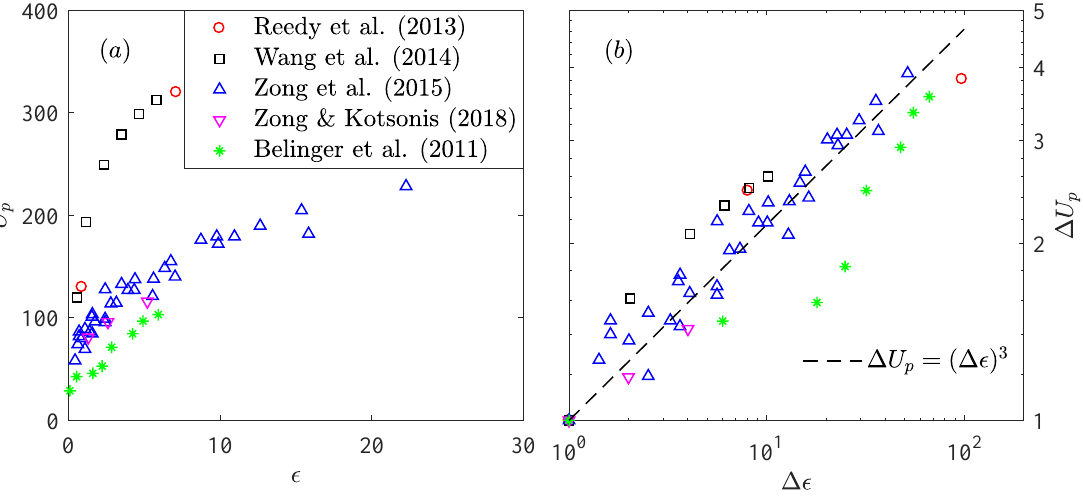
Figure 5. ( a ) Peak jet velocity at different non-dimensional energy deposition; ( b ) Relative variations of the peak jet velocity ( ∆ U p ) plotted against the relative increment of the non-dimensional energy deposition ( ∆ (cid:101)